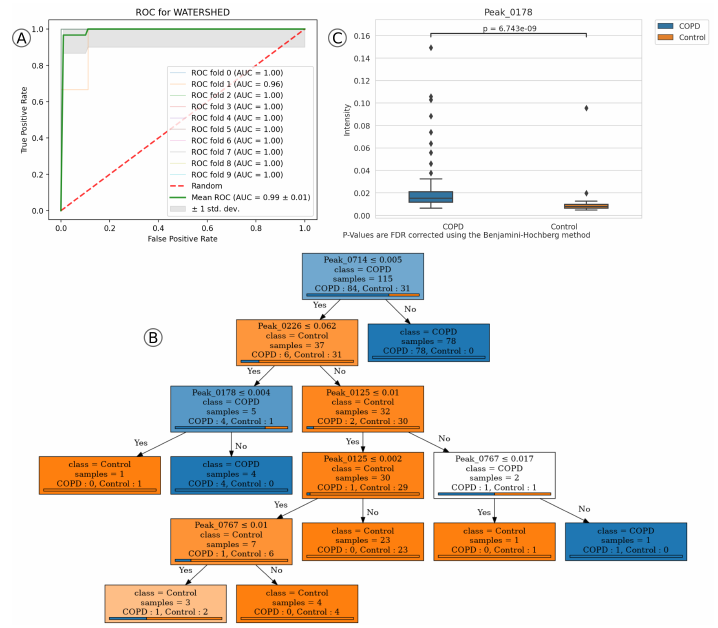
Figure 3. Receiver operating characteristic (ROC), boxplot and decision tree of top features of prediction model WATERSHED in “COPD” dataset. ( A ) ROC curve during the ten-fold cross validation. ( B ) Decision tree based on the highest ranked features from random forest classification. ( C ) Boxplot of Peak_0178